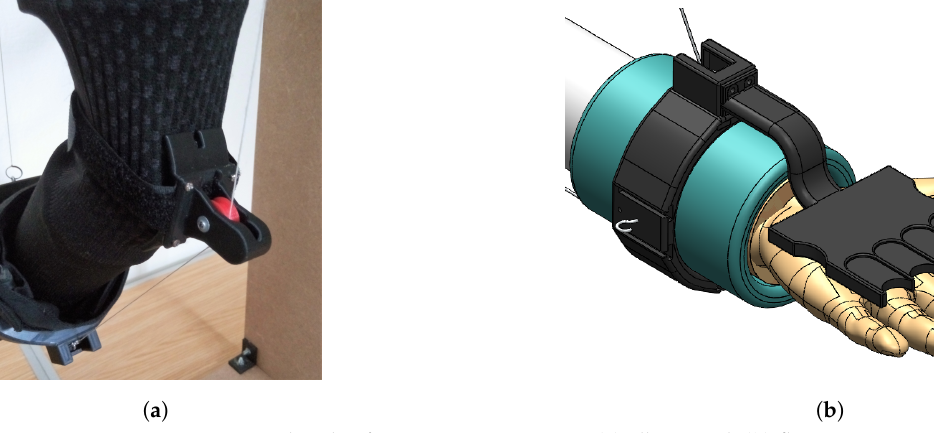
Figure 5. Design details of CADEL.3 in Figure 4: ( a ) elbow pad; ( b ) flexor spasticity